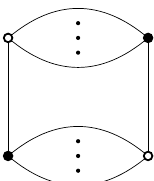
Figure 1. The four-vertex bubble for which the dots indicate multiple